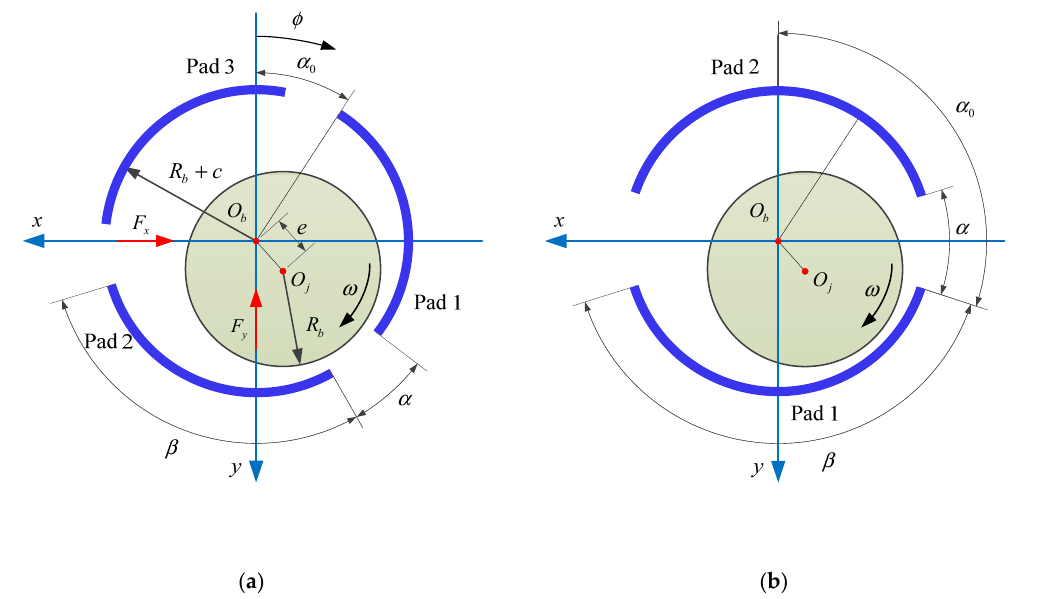
Figure 1. Schematic drawing of axial-groove gas bearing: ( a ) 3-axial grooved; ( b ) 2-axial grooved.